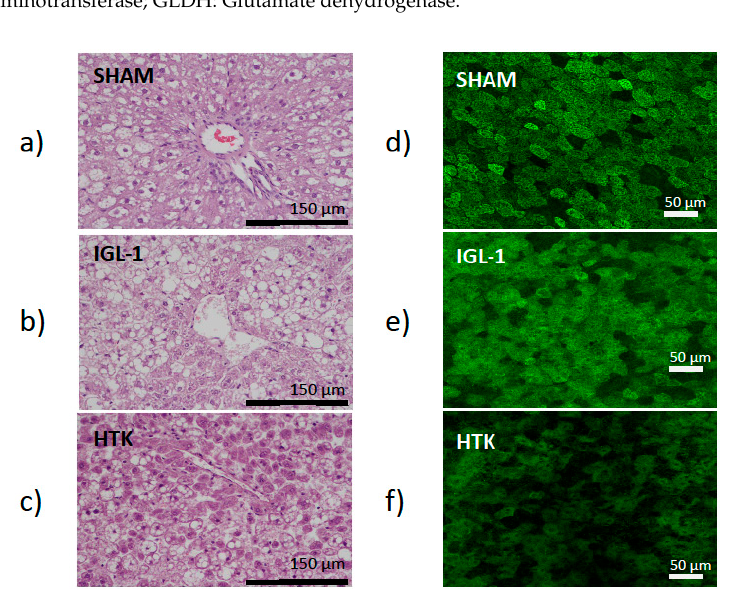
Figure 1. Effects of IGL-1 and HTK preservation solutions on histological changes in fatty liver grafts in cold storage. Left panel: Representative images of hematoxylin-eosin stained liver sections for each experimental group were taken with 20× lens. After hematoxylin-eosin staining (( a ) SHAM, ( b ) Institute Goeorges Lopez 1 (IGL-1), ( c ) Histidine-Tryptophan-Ketoglutarate (HTK)), samples were analyzed in a scale from 0 (no damage) to 4 (maximum damage). While control group average damage was considered 0, IGL-1 group was 1.67 and HTK 3.06. Right panel: Representative images of confocal microscopy findings on hepatic sections for each experimental group (( d ) SHAM, ( e ) IGL-1, ( f ) HTK).